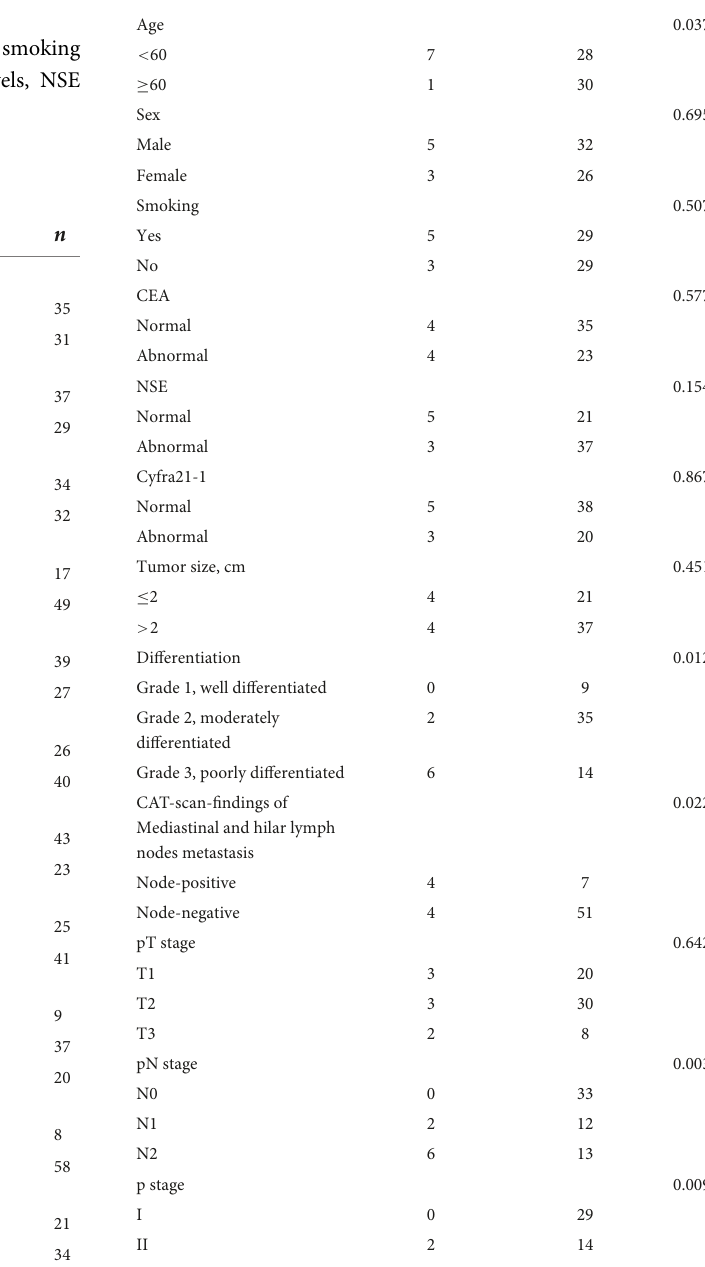
TABLE 2 Association between NTBL/NTBS and clinicopathological